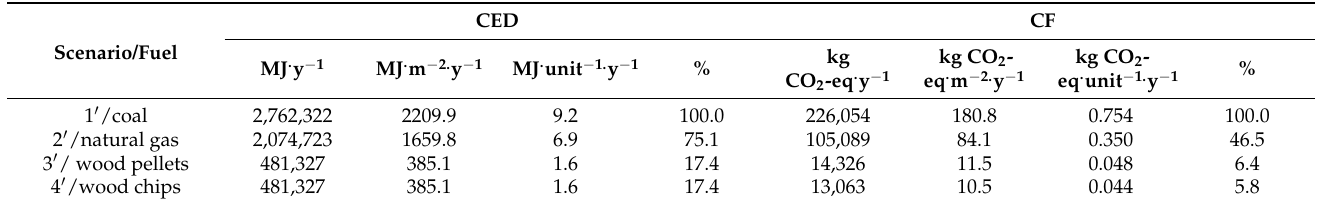
Table 8. CED and CF for individual scenarios expressed as absolute values, as well as specific values per unit area and per unit of a potted flower; GH operation of 273 days, from February till October.